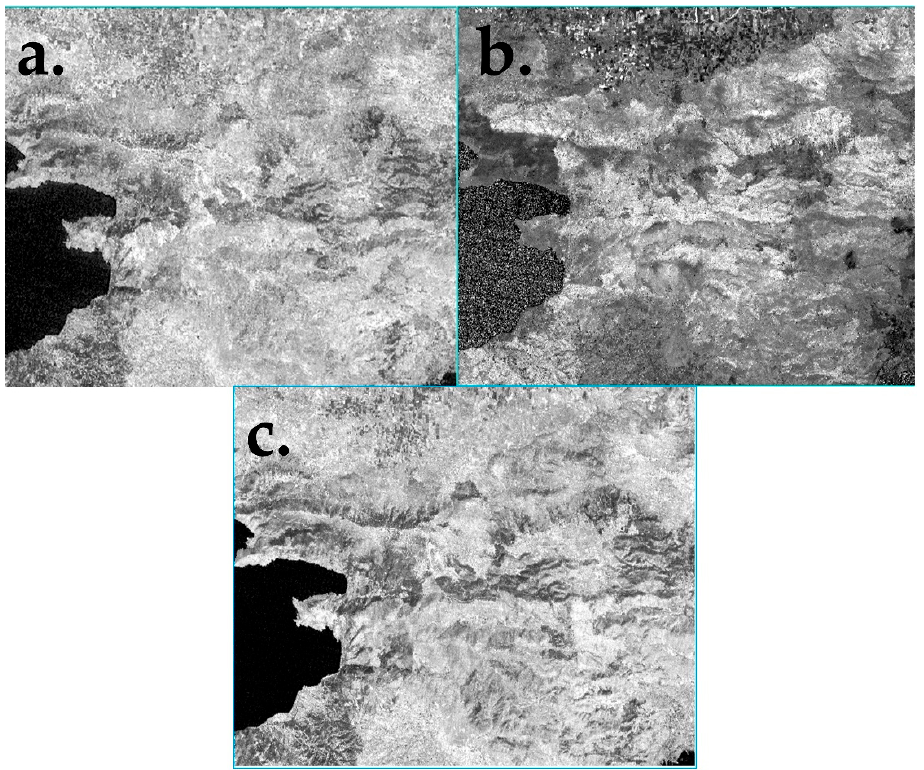
Figure 4. Final pseudo-color images of the years ( a ) 1993, ( b ) 2001 and( c ) 2010.